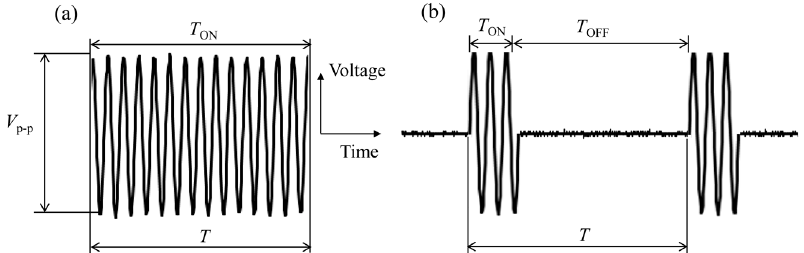
Figure 7. Waveform patterns of applied sinusoidal voltage: ( a ) continuous control, ( b ) burst control. Figure 7. Waveform Patterns of applied sinusoidal voltage: ( a ) continuous control, ( b ) burst